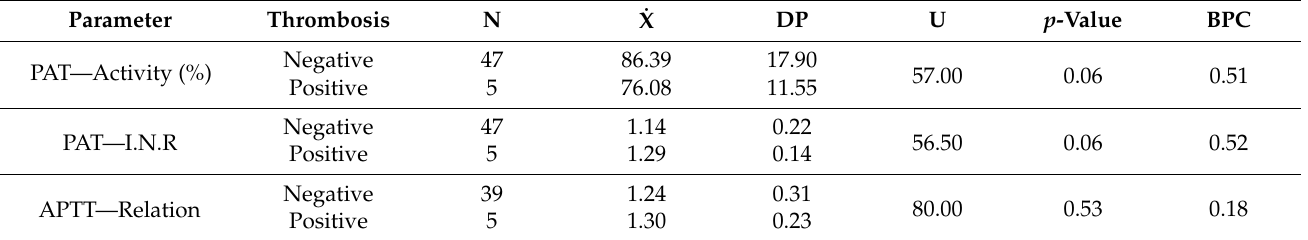
Table 5. Analysis of PAT and APTT laboratory tests in patients hospitalized with